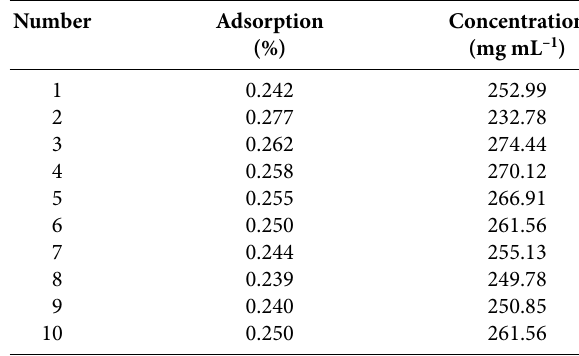
Table 4. Results of repeatability at concentration 250 mg.mL –1